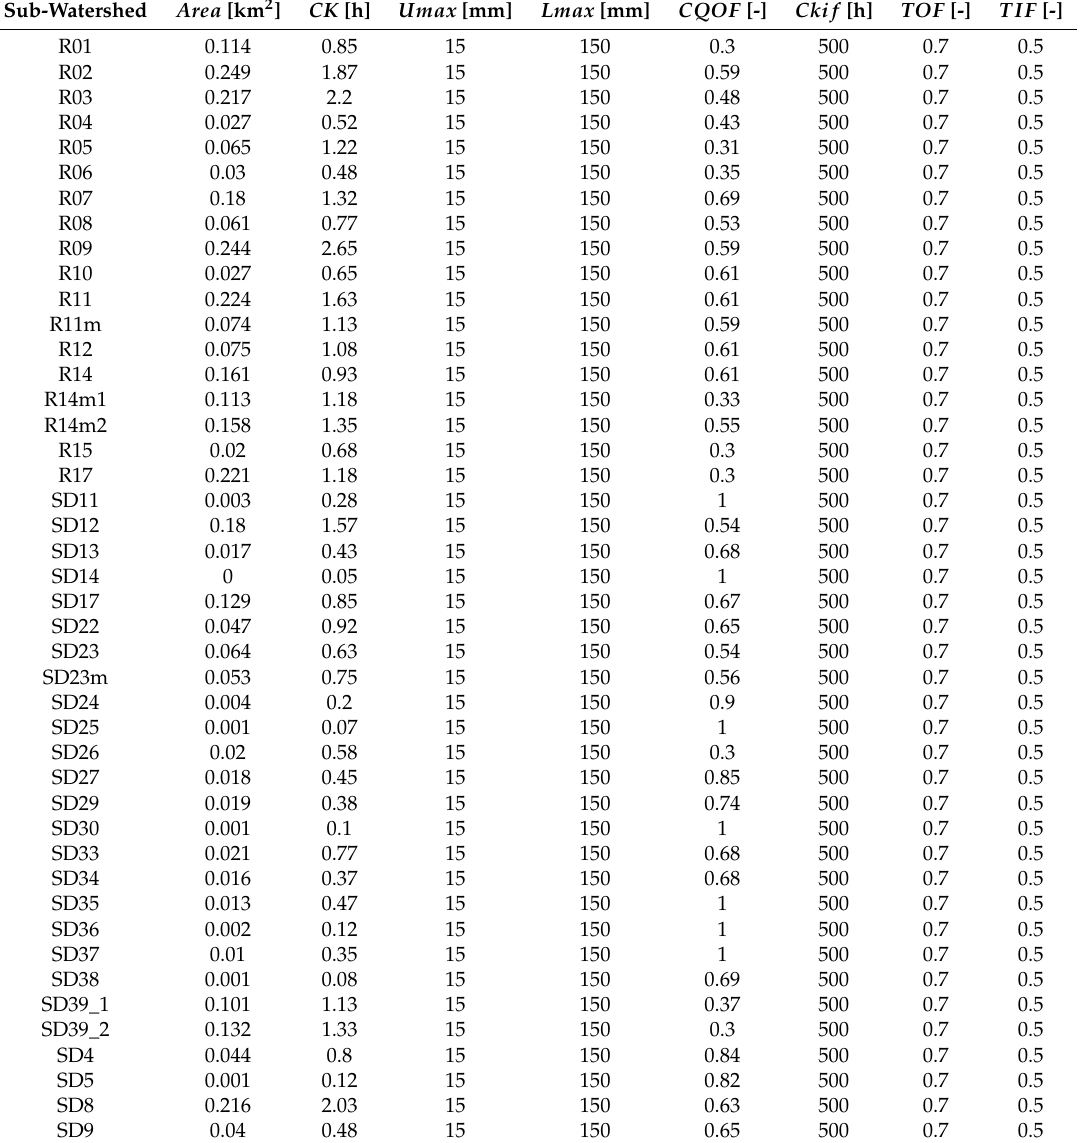
Table 4. Input parameters of MIKE models for urban sub-watershed discretisation in HHUs (Corace torrent, Calabria, Southern